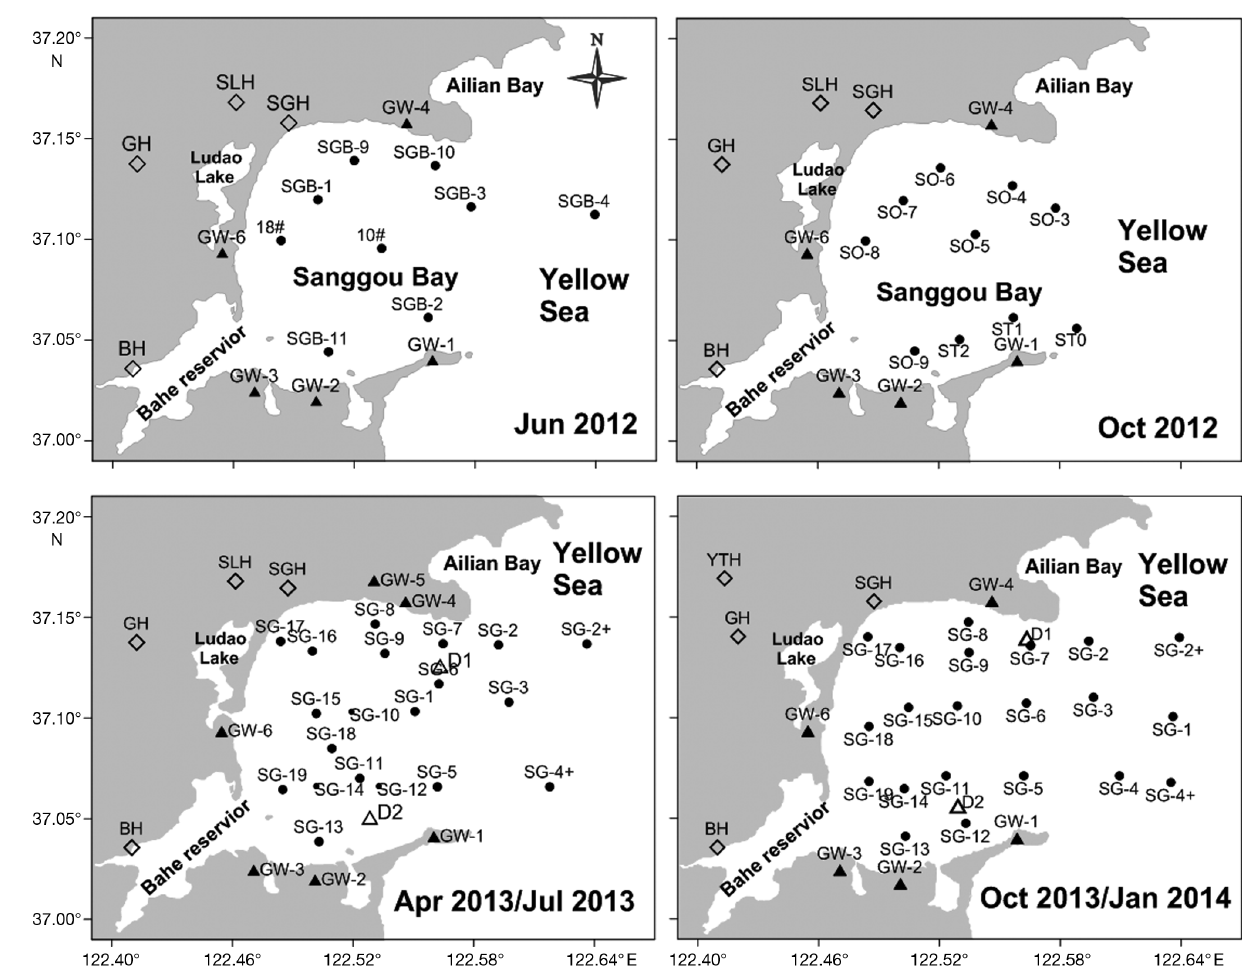
Fig. 2. Sampling stations in Sanggou Bay for the cruises during 2012 to 2014. ( e ) River stations; ( m ) groundwater stations (BH: Bahe; GH: Guhe; SLH: Shilihe; SGH: Sanggouhe; YTH: Yatouhe); ( d ) bay stations; ( n ) anchor